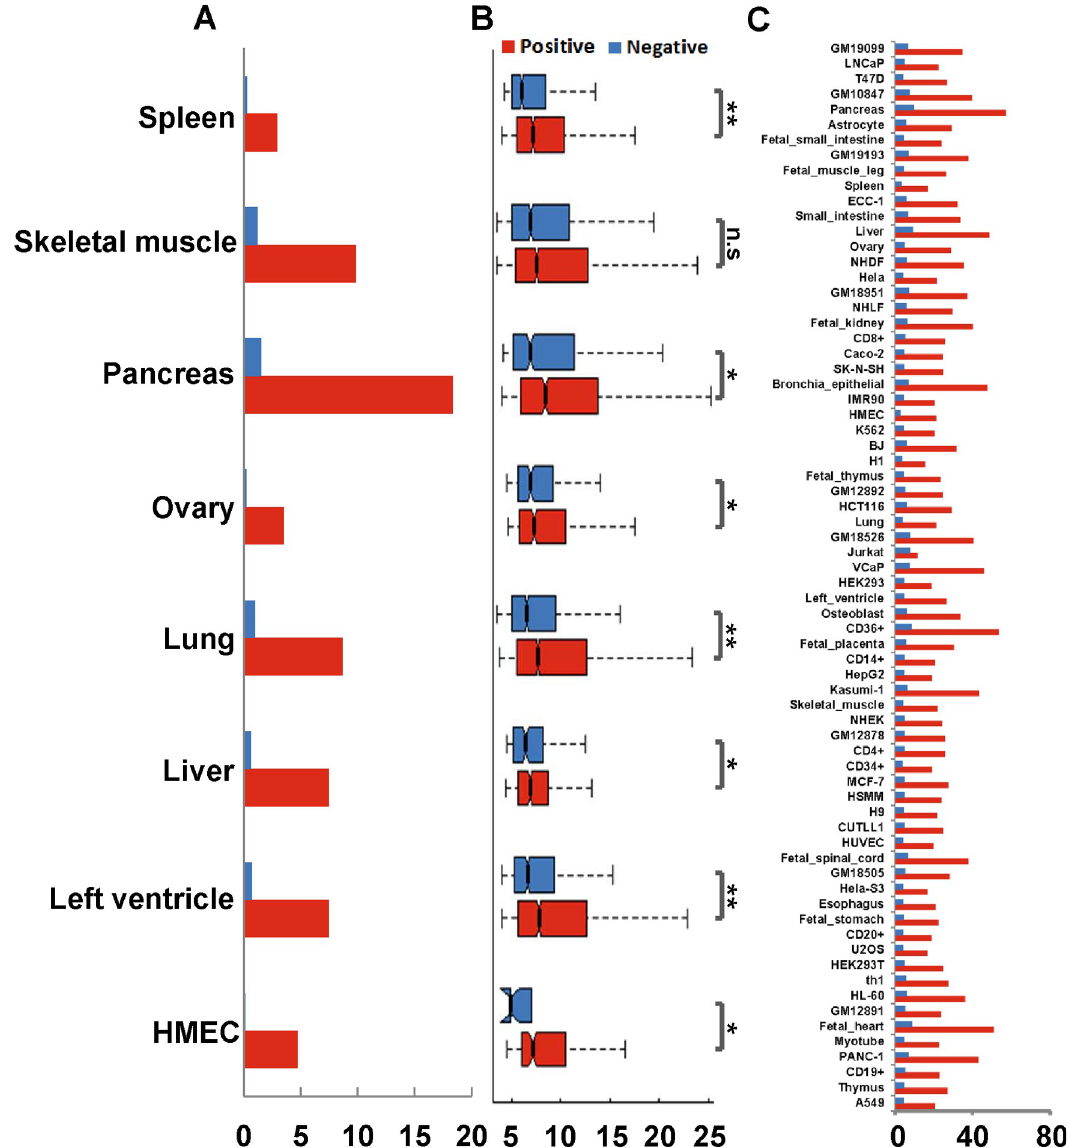
Fig 6. Predicted EG interactions are enriched for eQTLs. (A) Percentages of tissue-specific eQTLs overlapping with interacting and non-interacting pairs, respectively. The eQTL datasets were from the corresponding tissue types that we used to predict enhancer-target gene pairs. (B) Significance (p-values) of eQTLs overlapping with interacting and non-interacting enhancer-target pairs. � P < 0.01; �� P < 1e-16; n.s. not significant. (C) Percentages of interacting and non-interacting pairs overlapping with eQTLs combined from 48